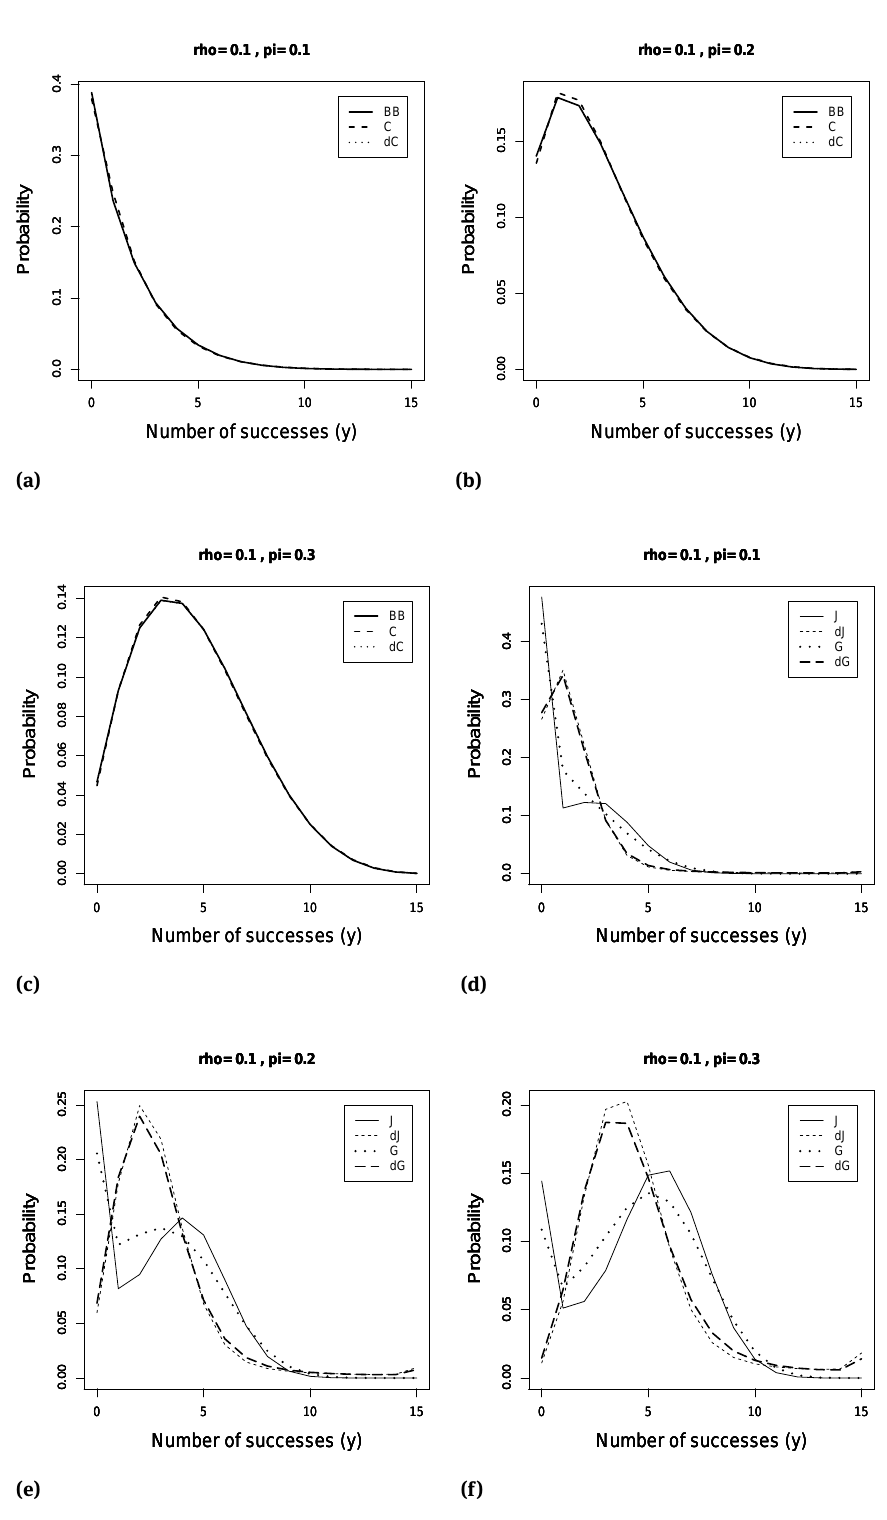
Figure 1: A comparison of the probability mass function for cluster size 15 under some small clusters models, for ρ = 0.1 and π = 0.1, 0.2,